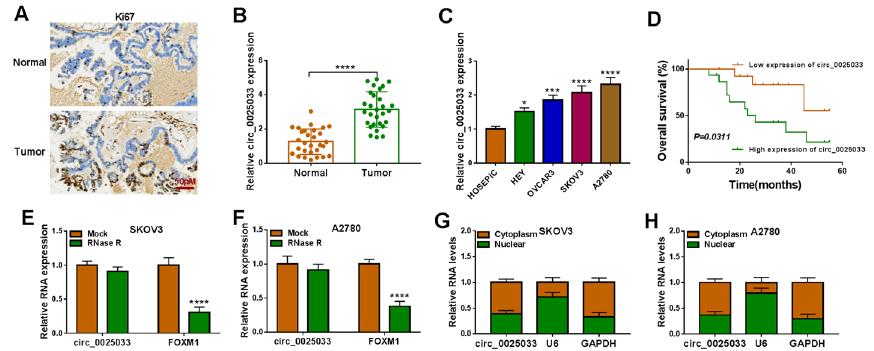
Fig. 1 Overexpression of circ_0025033 in ovarian cancer. A IHC analysis detecting Ki67 content in tumor tissue. B and C qRT-PCR analysis of circ_0025033 content in tissue samples, HOSEPiC cells, and ovarian cancer cells (HEY, OVCAR3, SKOV3, and A2780). D Kaplan–Meier curves exhibiting survival rate of sufferers of ovarian cancer with high or low level of circ_0025033. E and F Expression of circ_0025033 and FOXM1 determined